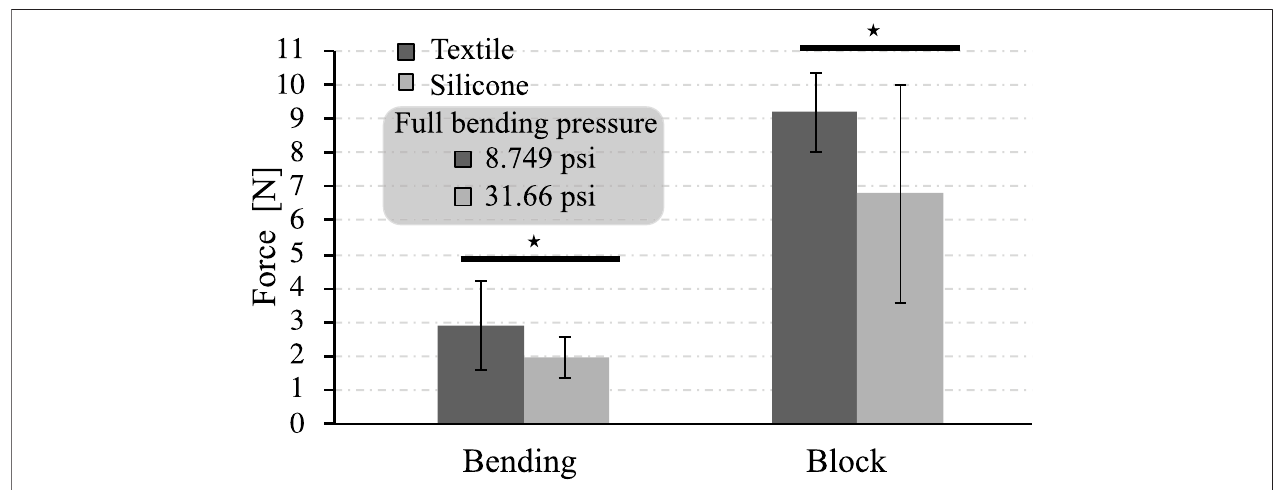
FIGURE 10 | The force generated by the actuators according to the two different setups and the comparison full bending pressure. The symbol + represents a signi fi cant difference between the two groups based on statistical analysis tests ( p < 0.05).